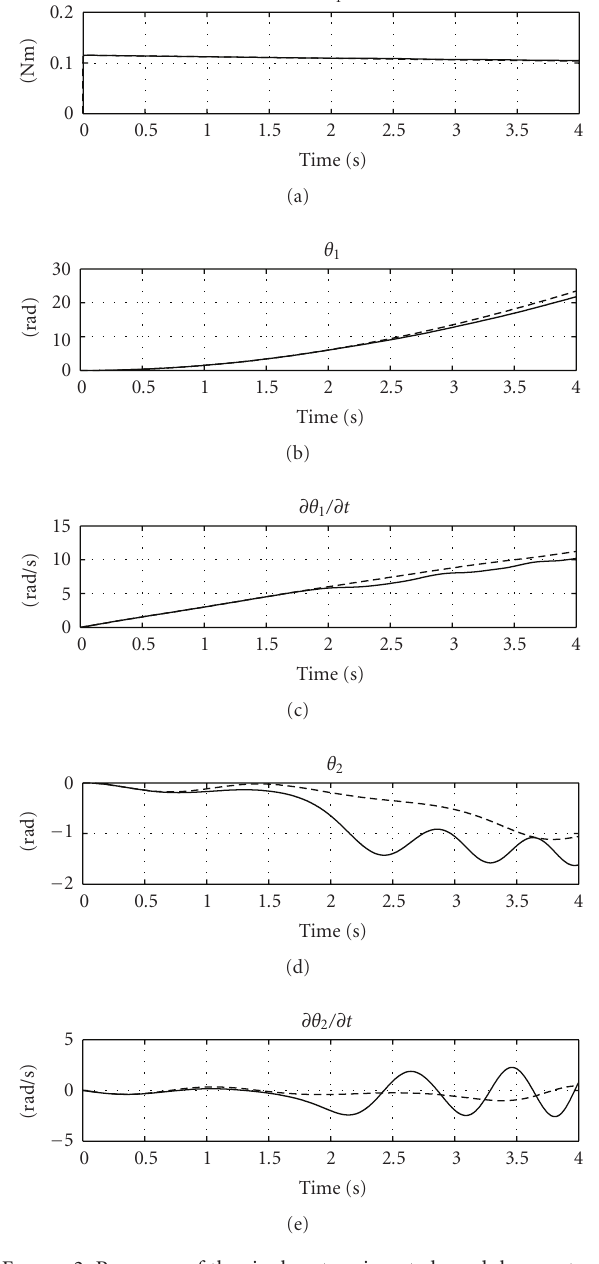
Figure 2: Response of the single rotary inverted pendulum system to a 10 V step input. Solid line represents the plant with the full inertia tensor J 2 yy = J 2 zz = J 2 ; the dashed line represents the plant only considering J 2 zz ( J 2 yy =